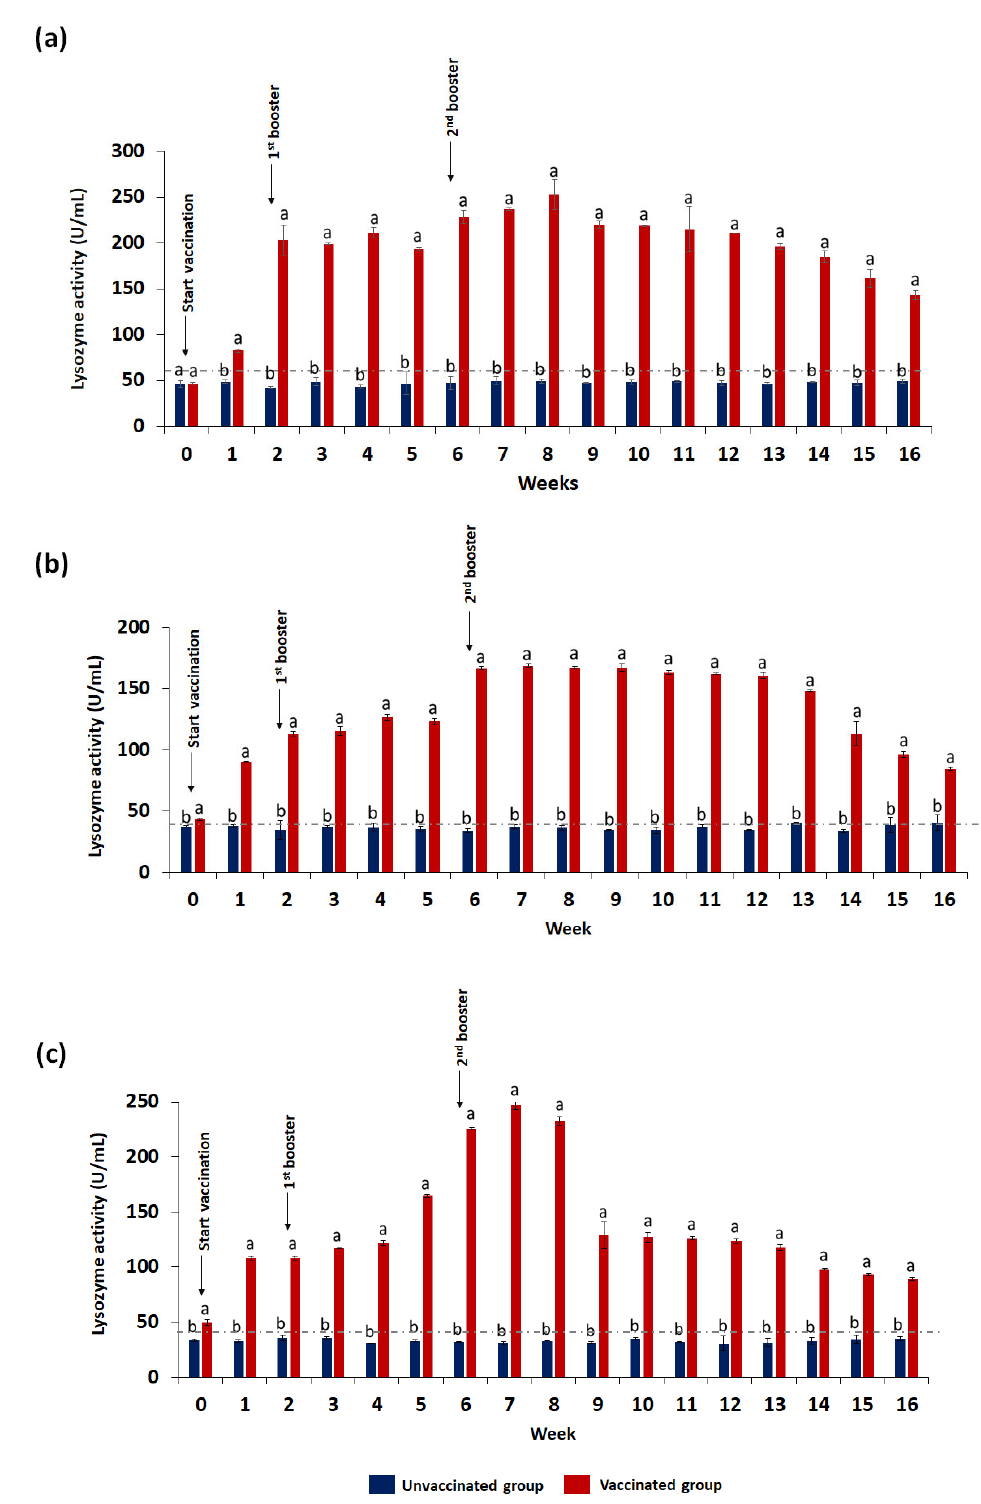
Figure 7. Lysozyme activity in serum ( a ), gut lavage fluid ( b ), and skin mucus ( c ) of red hybrid tilapia collected per time point ( n = 3). The values are the mean ± standard deviation in triplicate samples. One-way ANOVA was performed with the Tukey–Kramer post hoc test to compare lysozyme activity between vaccinated and unvaccinated groups. Means with different superscript letters (a–b) differ significantly at p ≤ 0.05 (one ‐ way ANOVA) significance level.